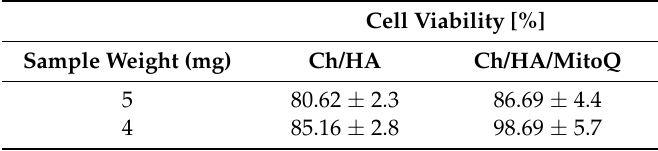
Table 1. Cytotoxicity studies of Ch/HA and Ch/HA/MitoQ